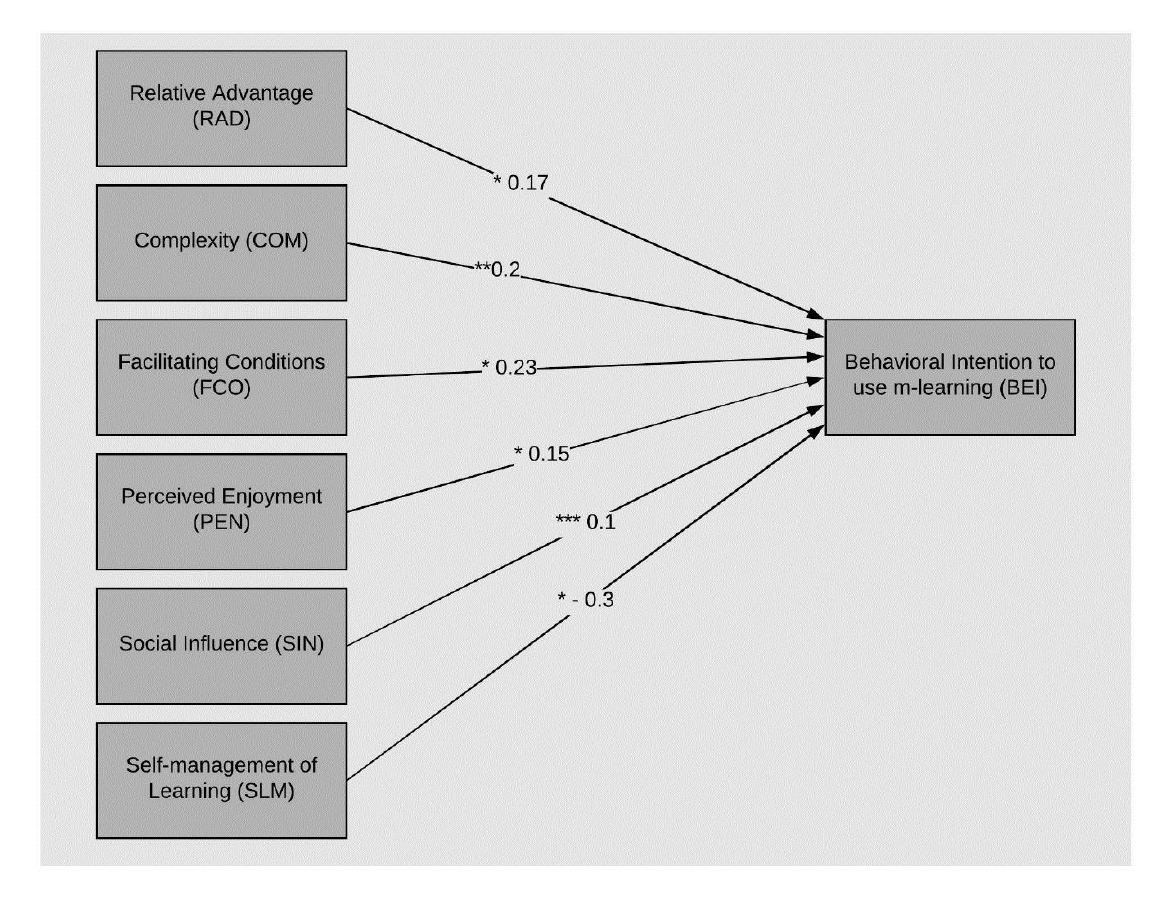
Figure 2. Structural equation modeling